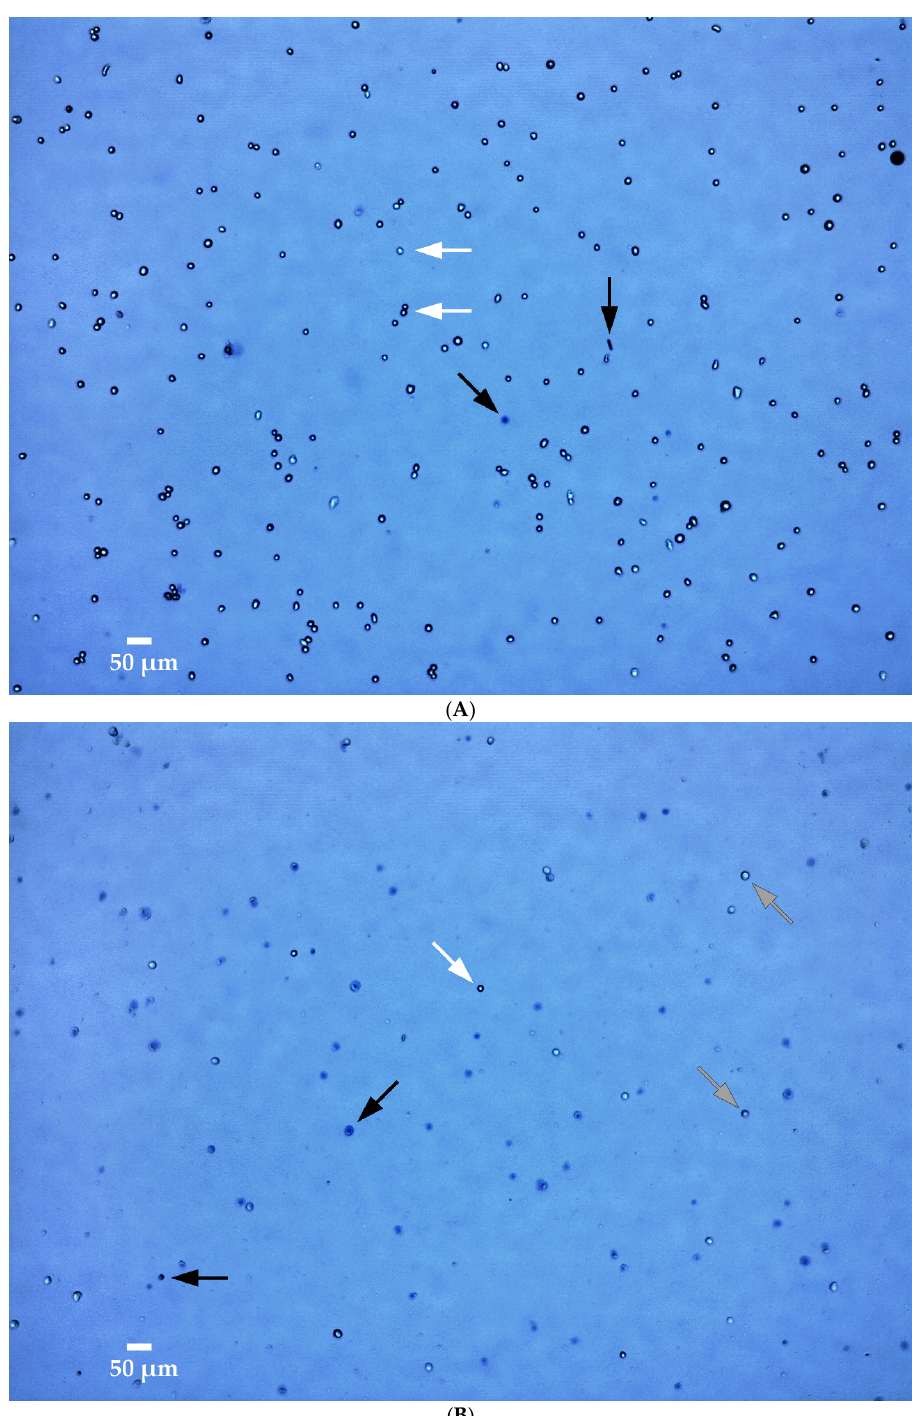
Figure 9. Example of cell viability assay (Trypan blue assay) performed on the cell suspension maintained at 37 °C ( A ) without the application of irreversible electroporation, and ( B ) after application of irreversible electroporation (electric field strength of 1250 V · cm − 1 ). The length of the scale bar in both images represents 50 µ m. Vital cells are noted by light blue circles with dark edges (indicated by white arrows), while electroporated cells are noted by blue circles with less dark edges (indicated by gray arrows) and dead or dying cells are noted by dark blue, or dim circles (indicated by black arrows). Note that the cell viability was determined using an automated bright-field cell counter (LUNA TM Automated Cell Counter, Aligned Genetics, Anyang-si, Inc., South Korea) with a lens magnification of